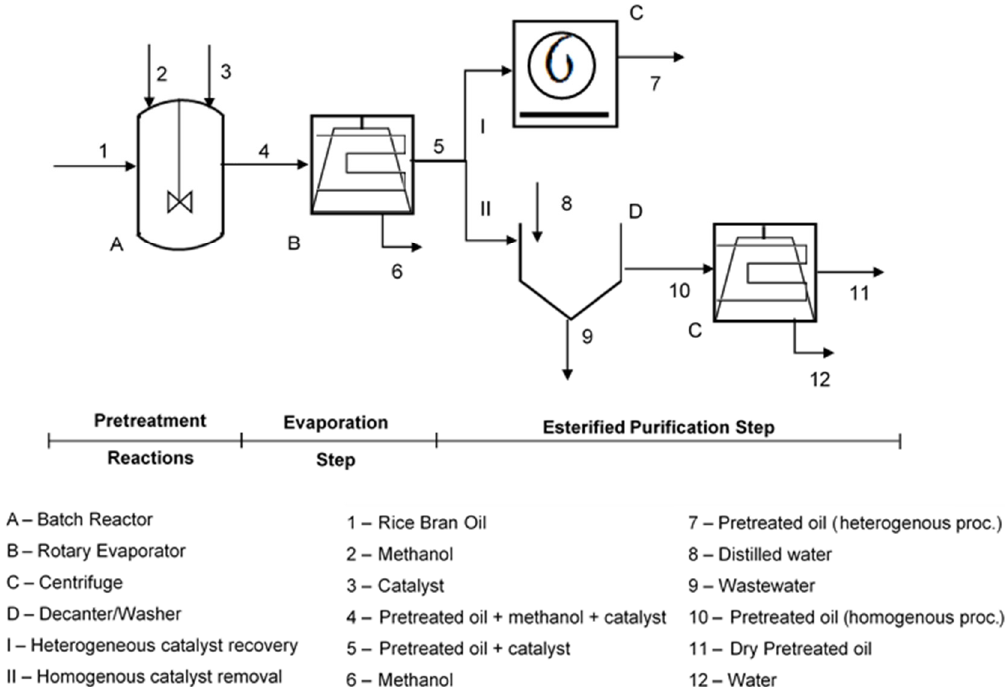
Figure 2. Diagram of RBO pretreatment using both enzymatic esterification and homogeneous acid esterification.